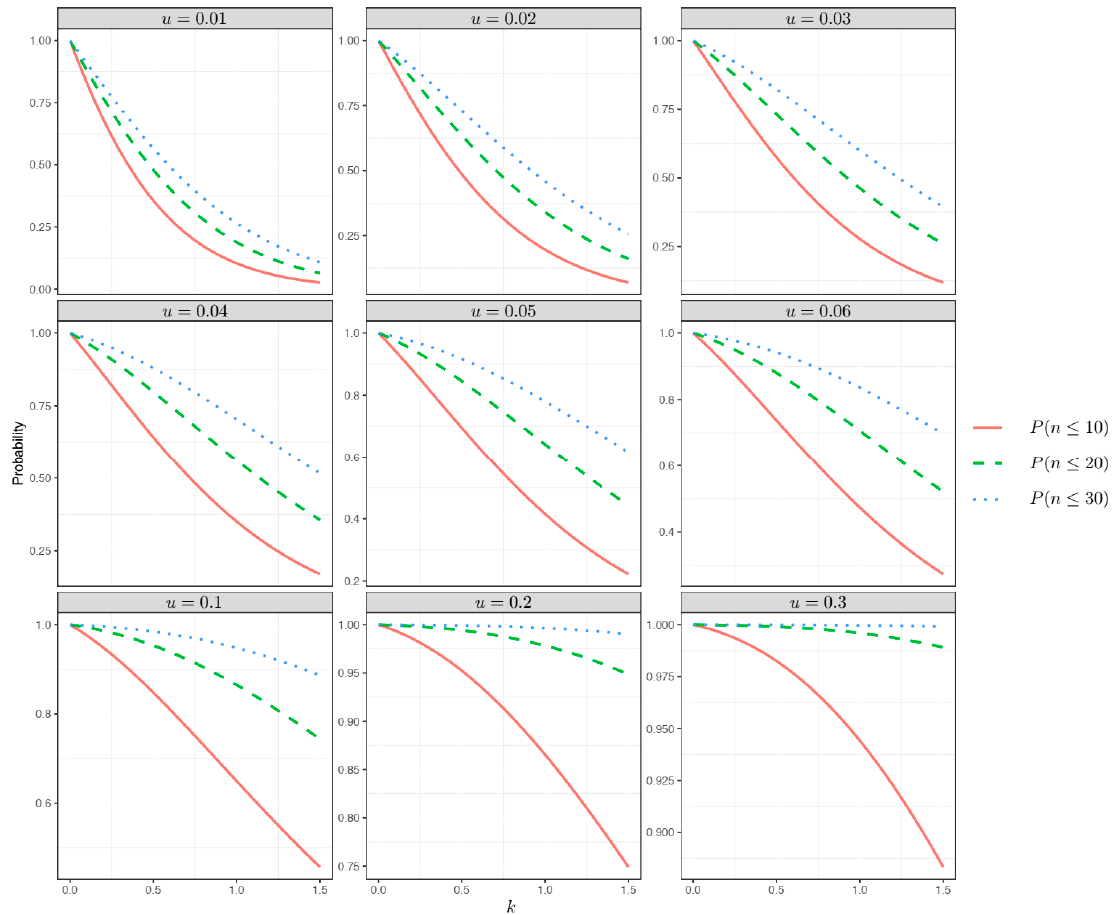
Figure 1. Relationships between the shape parameter k and the summed probability of having a small population size ( ≤ 10, 20, 30) for a single species under the conditions of different fixed u values (calculated using Equation (1)). In all subplots, the theoretical area size A was fixed at 1.